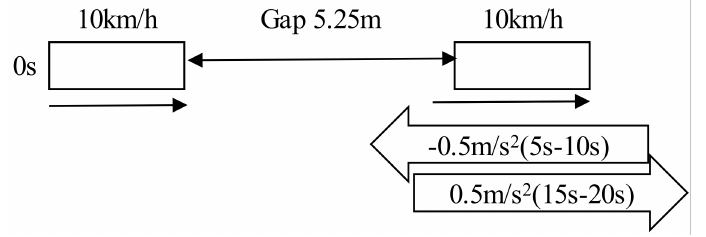
Figure 1. Representation of the following behaviour (example case).